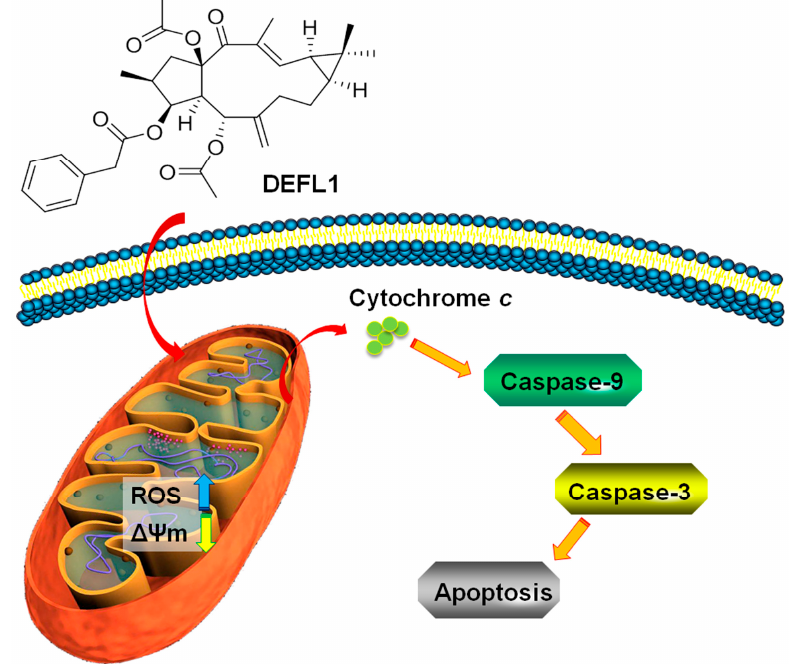
Figure 7. Proposed mechanism of DEFL1 regarding apoptosis inducement in A549 cells.